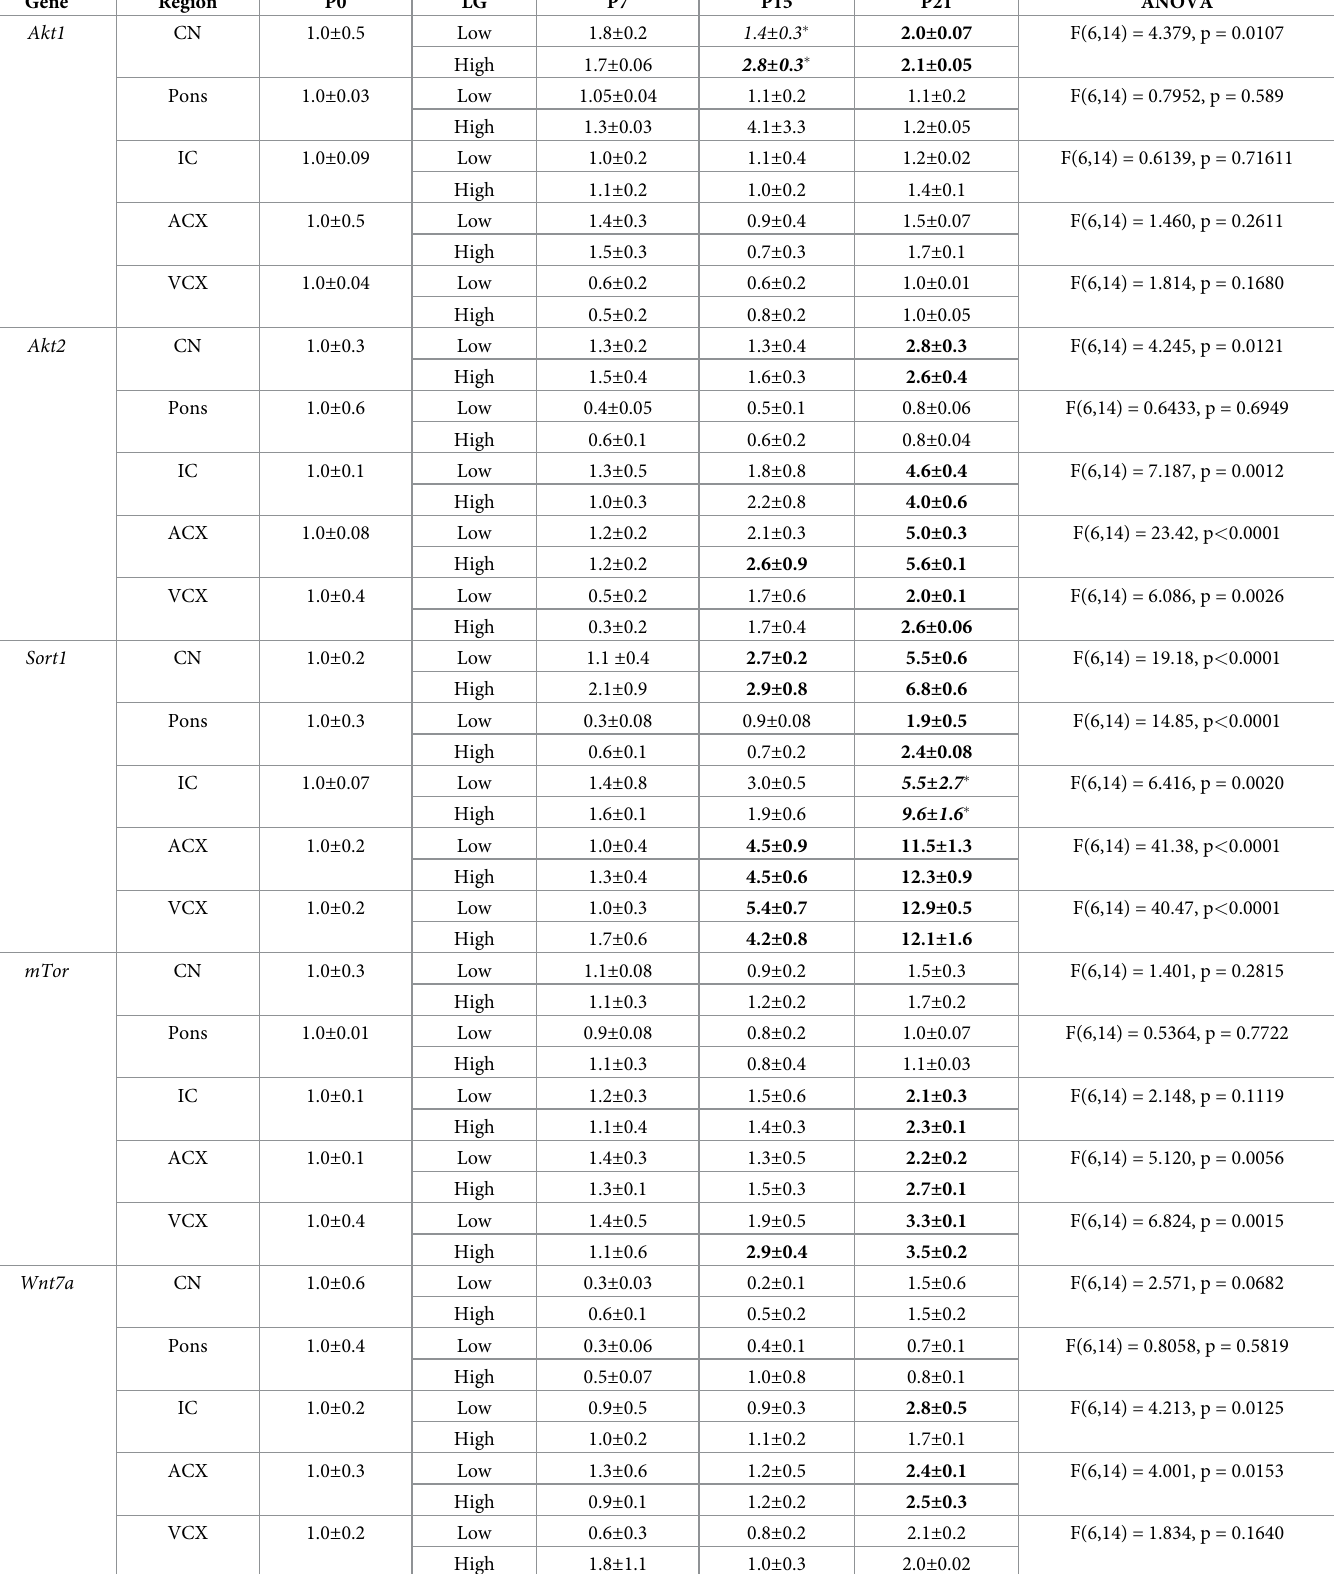
Table 5. Fold-change in brain region expression of genes involved in downstream signaling.